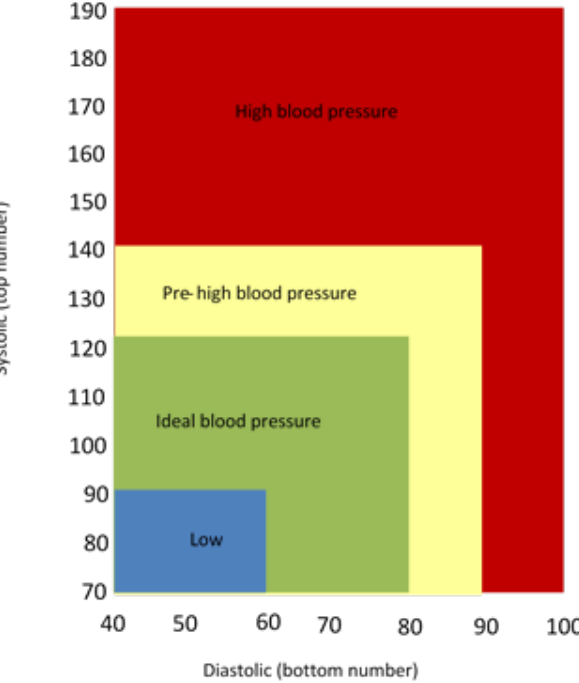
Figure 6. Blood pressure ranges.